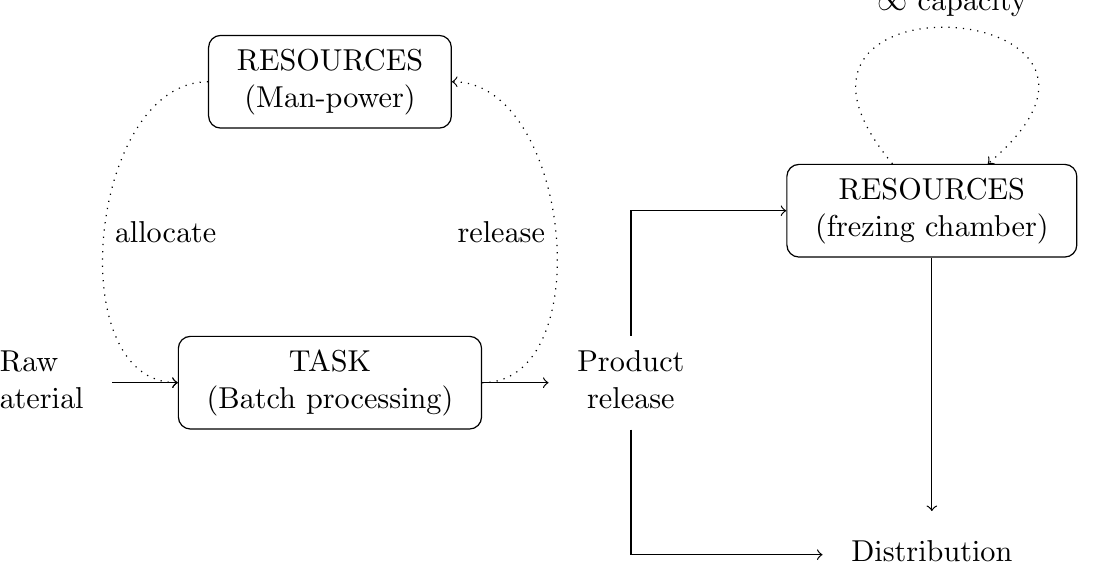
Figure 2. Resource-Task Network